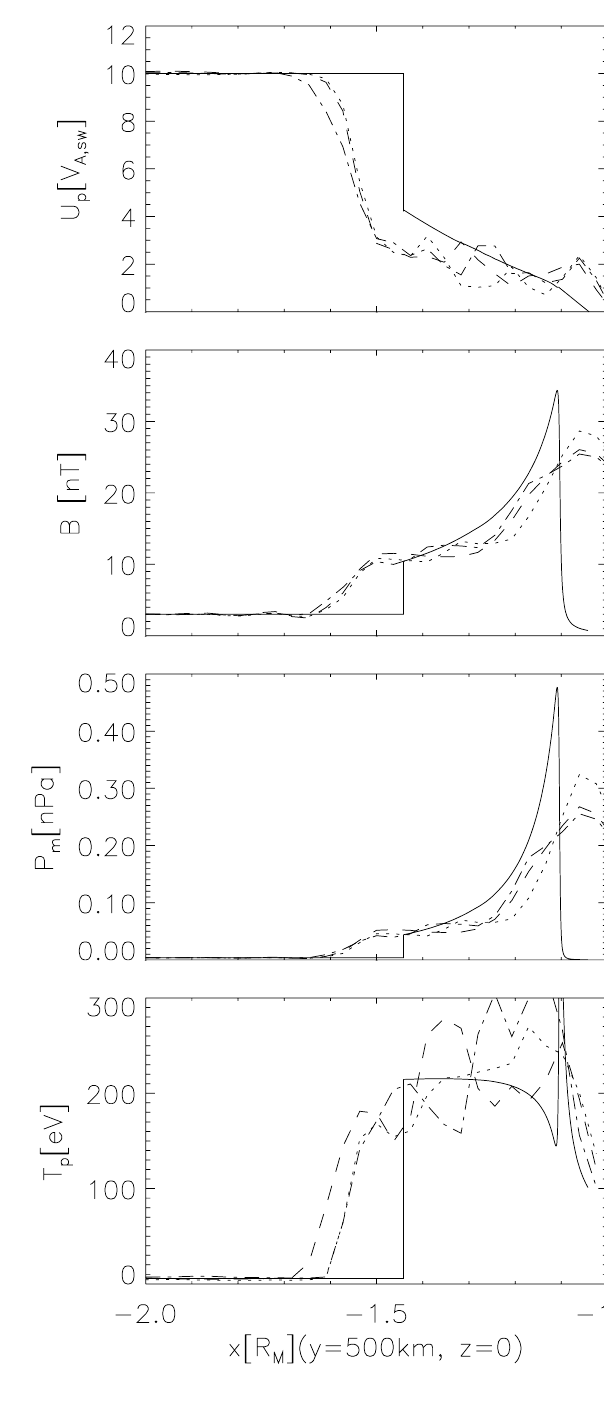
distance could be related to the insufficient effective ioniza- tion rate which is the input parameter of our models. Another reason is that related to the ionospheric electron temperature is T e,h , which is not a well known input parameter in the hy- brid simulation. In the hybrid run we used T e,h =3000 K. A